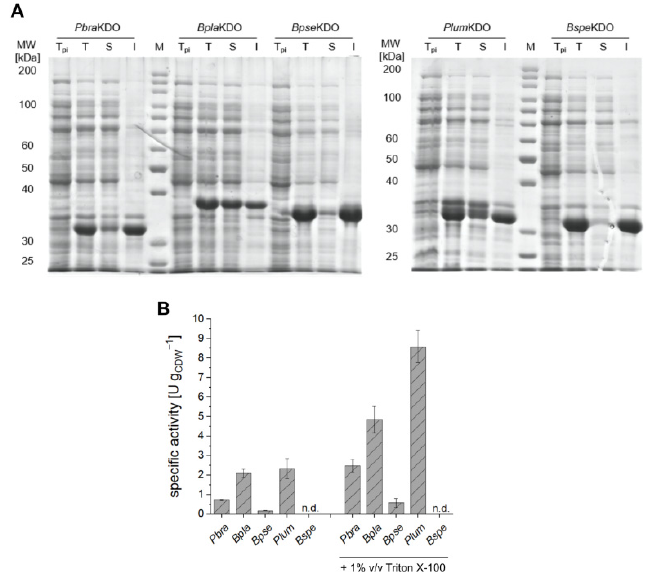
Figure 6. ( A ) SDS-PAGE gel image of the protein content of E. coli BL21 (DE3) whole-cell biocatalysts. M, marker; T pi , total protein pre-induction; T, total protein; S, soluble protein fraction; I, insoluble protein fraction. Molecular weights of the proteins of interest are Pbra KDO 32.5 kDa, Bpla KDO 31.5 kDa, Bpse KDO 30.5 kDA, Plum KDO 31.8 kDa and Bspe KDO 30.2 kDa. ( B ) Specific whole-cell biocatalyst activities, assays were performed in 0.5 mL 50 mM KPi pH 7.4 with 1 g CDW L − 1 , 10 mM Lys, 20 mM α -KG, 5 mM L (+)-ascorbic acid and 1 mM FeSO 4 for 1 h at 30 ◦ C in an Eppendorf ® ThermoMixer ® C at 500 rpm. n.d., not detected. Standard deviations are a result of two biological replicates.